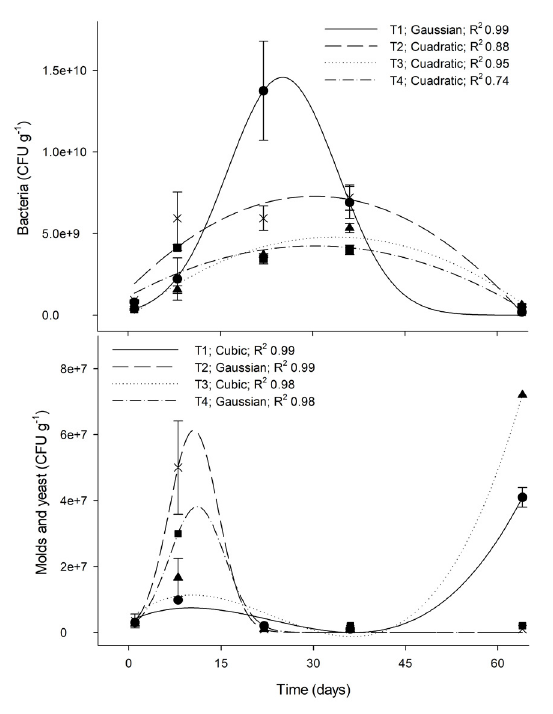
Figure 6: Total CFU g -1 compost of bacteria, molds and yeast in static piles (T1 ● prickly pear cactus+BP; T2 ᵡ moringa+BP; T3 ▲ prickly pear cactus; T4 ▀ moringa) over 65 days of analysis. Means (±SD) were calculated from five replicates for each treatment and sampling day. Statistically different (Tukey test,